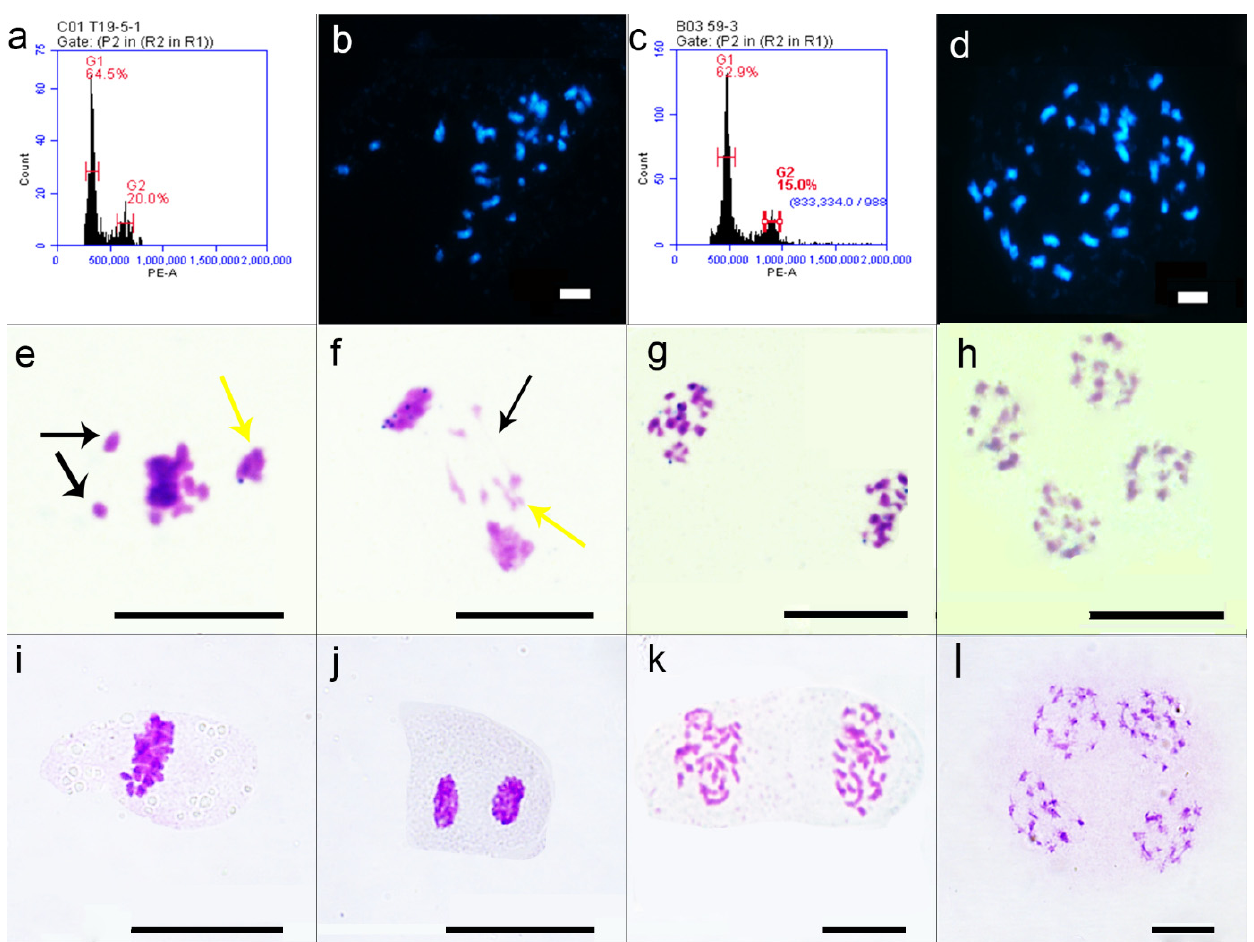
Figure 2. Part of F 1 and induced F 1 flow cytometry and observation of ordinary cells: ( a ) T19-5 flow cytometry diagram; ( b ) T19-5 root tip mitosis observation diagram; ( c ) W59 flow cytometry diagram; ( d ) W59 root tip mitosis observation diagram; ( e ) T19-5 meiosis prophase I, the black arrow points to the monovalent body, the yellow arrow points to the multivalent body; ( f ) T19-5 meiosis anaphase I, the black arrow points to the chromosome bridge, and the yellow arrow pointing to the chromosome bridge refers to lagging chromosomes; ( g ) T19-5 post meiotic stage I; ( h ) T19-5 tetrad period; ( i ) W59 meiotic prophase I; ( j,k ) W59 post meiotic stage I; ( l ) W59 tetrad period. Ruler = 10 μ m.